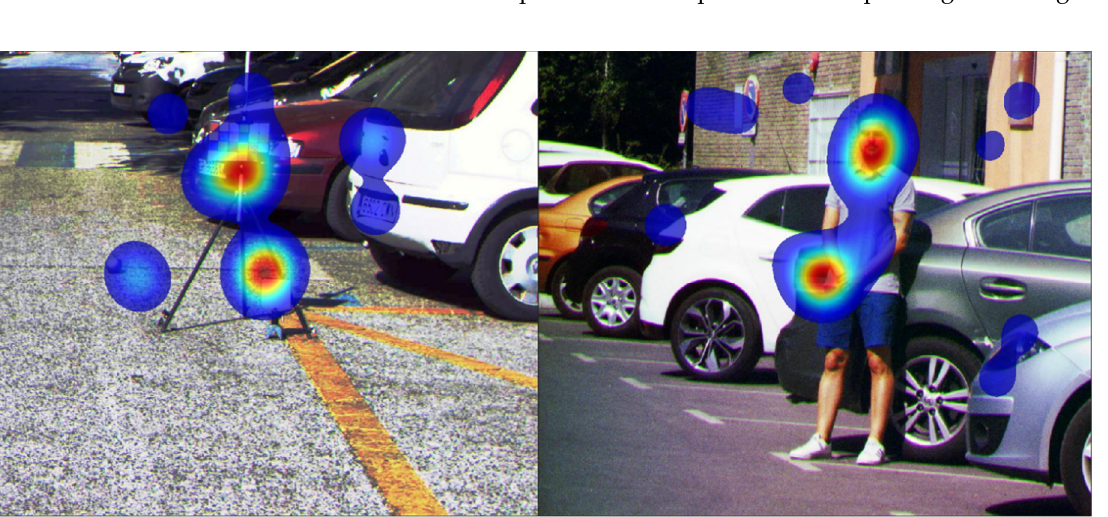
Figure 4. Two examples of accumulated heat maps overlaid on top of their corresponding images.